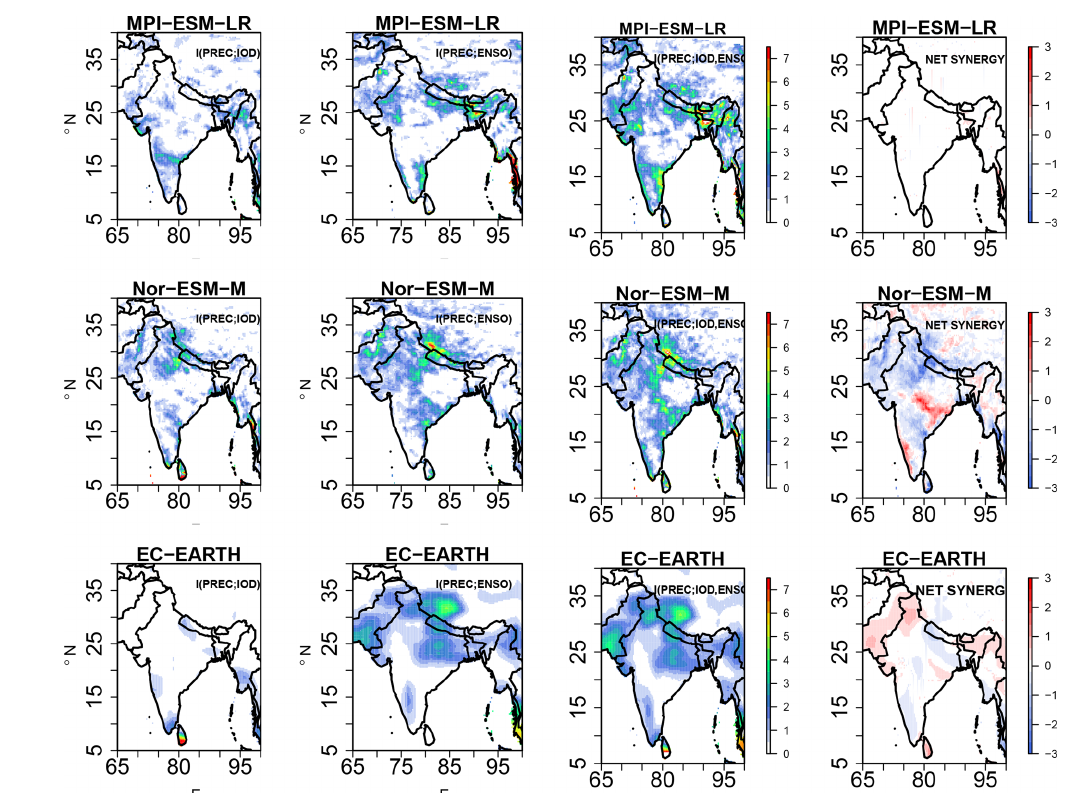
Figure 11. Information exchange from I (PREC; IOD), I (PREC; ENSO), two-source information exchange I (PREC; ENSO, IOD), and net synergy × 10 − 2 nats for the downscaled COSMO-crCLM simulations for JJAS (1951–2005). Only significant values at 95% confidence intervals are